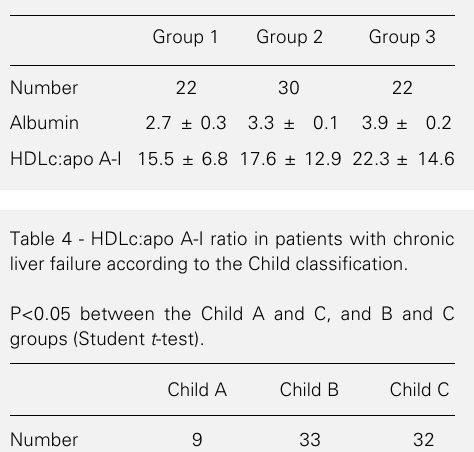
Table 3 - HDLc:apo A-I ratio in patients with chronic liver failure as a function of serum albumin levels (g/dl).